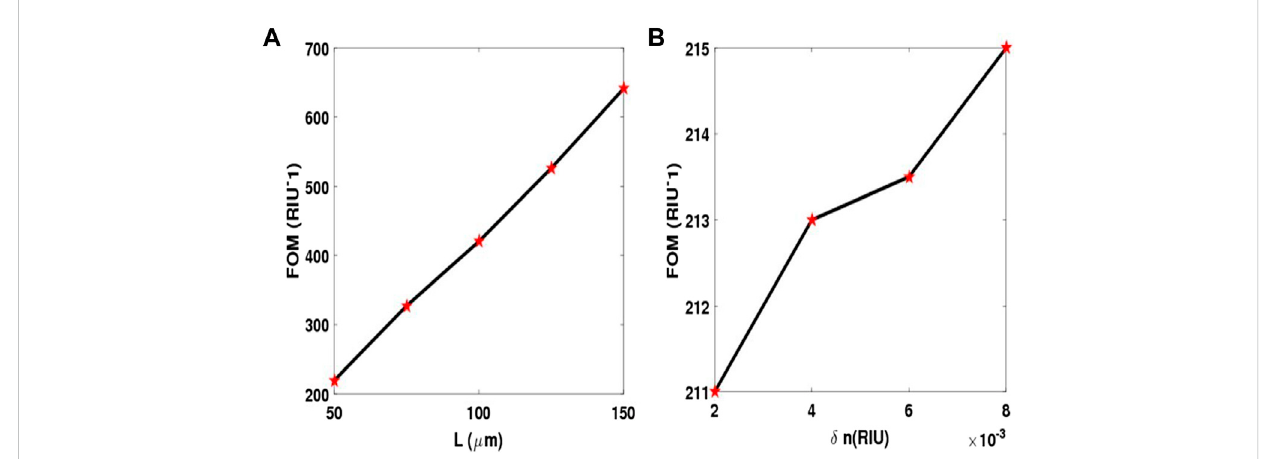
FIGURE 8 (A) The FOM versus the length of the sensing arm of the MZI. (B) The FOM versus the variations in sensing wavelength from water (n different medium index (n 2 ) using L Sensing = 50 μ m.